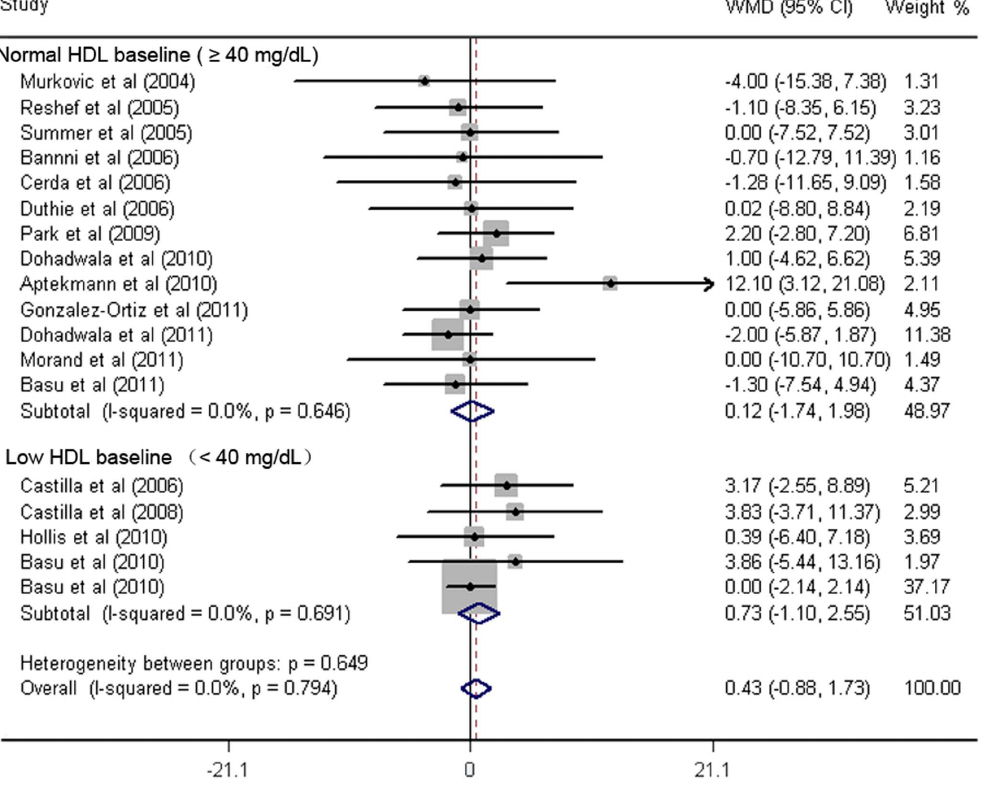
Figure 3. Meta-analysis of effects of fruit juice on high-density lipoprotein-cholesterol (HDL-C) concentrations. The result was obtained from a fixed-effects model. Sizes of data markers indicate the weight of each study in this analysis. The basis of classification of HDL-C is referred to the National Cholesterol Education Program guidelines, Adult Treatment Panel III. WMD, weighted mean difference.